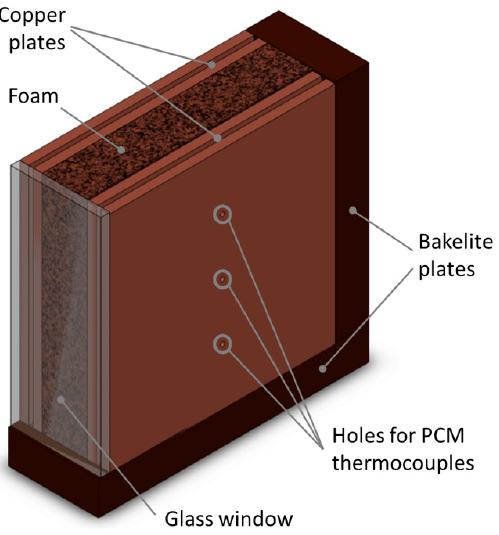
Figure 2. Foam block with bakelite plates.